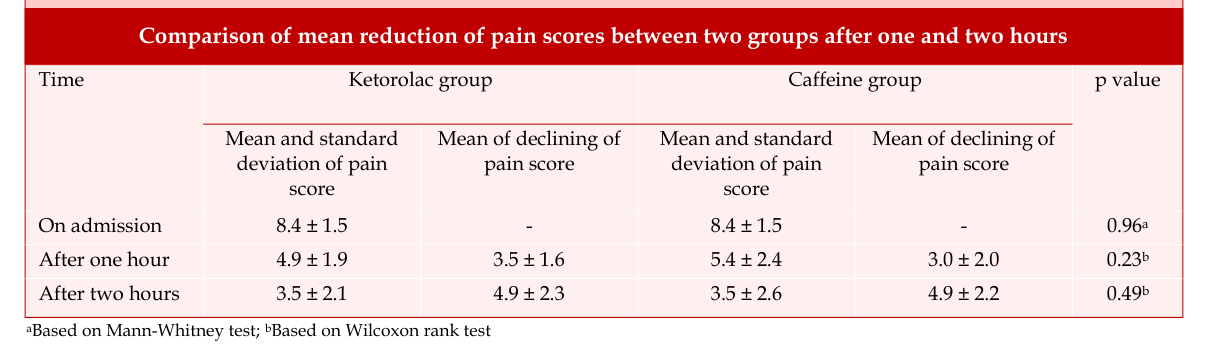
Comparison of mean reduction of pain scores between two groups after one and two hours